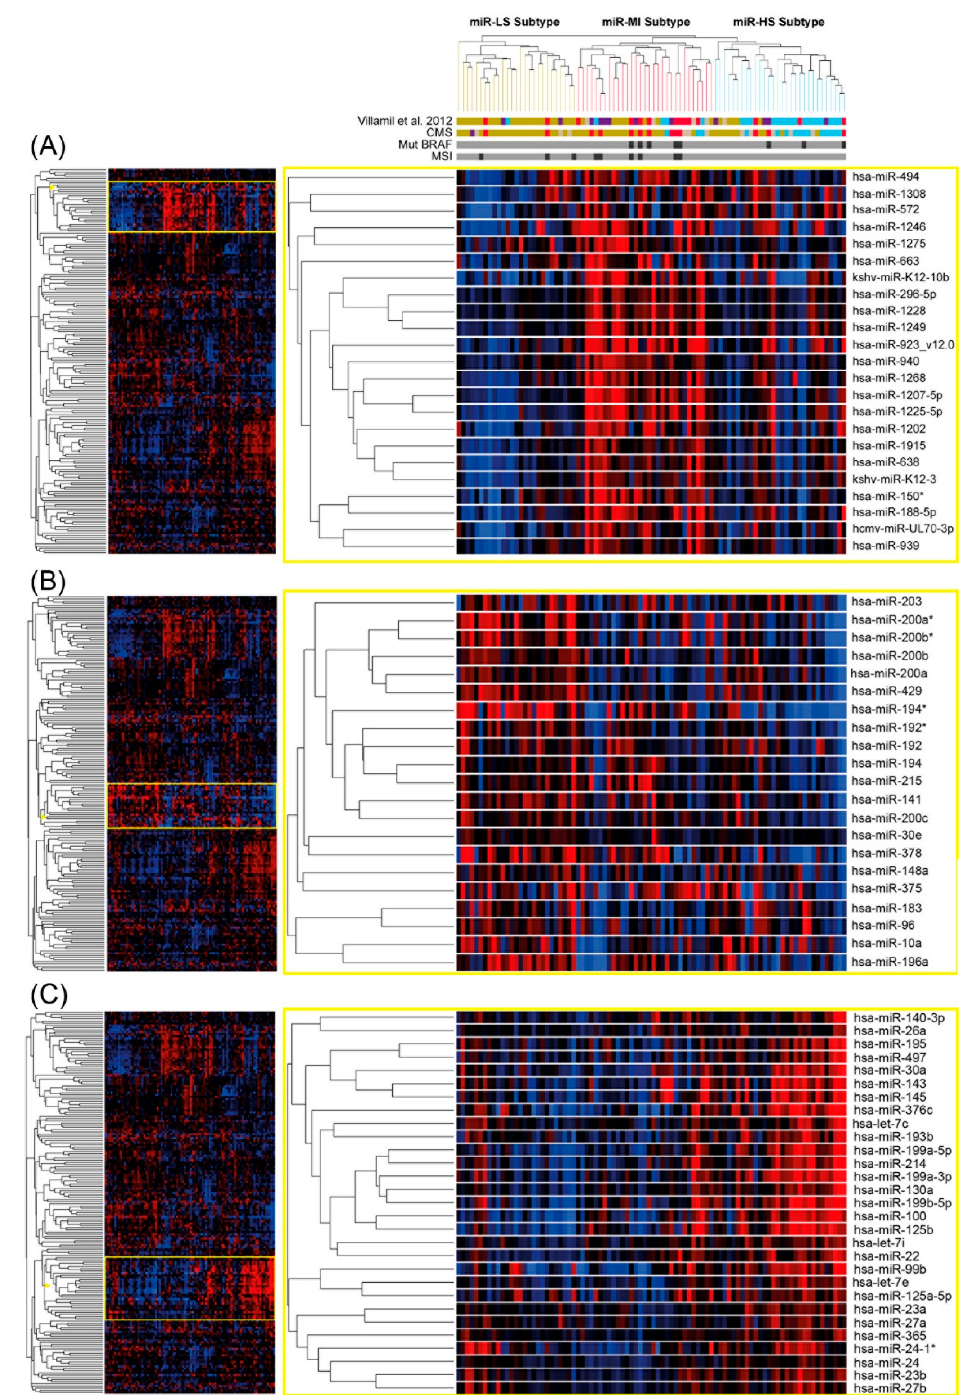
Figure 2. MicroRNAs distribution between Subtypes. ( A ) miRNA-Cluster-A: miRs down-regulated in the miR-LS-subtype and up-regulated in the miR-MI-subtype (23 miRs located in the heatmap between the 7th and the 29th miRs). ( B ) miRNA-Cluster-B: miRs inhibited in the miR-HS-subtype (21 miRs located in the heatmap between the 89th and the 109th miRs). ( C ) miRNA-Cluster-C: miRs upregulated in the miR-HS-subtype (29 miRs located in the heatmap between the 114th and the 142nd miRs). Heatmap intensities: 3.099 (red) to − 3.099 (dark blue).